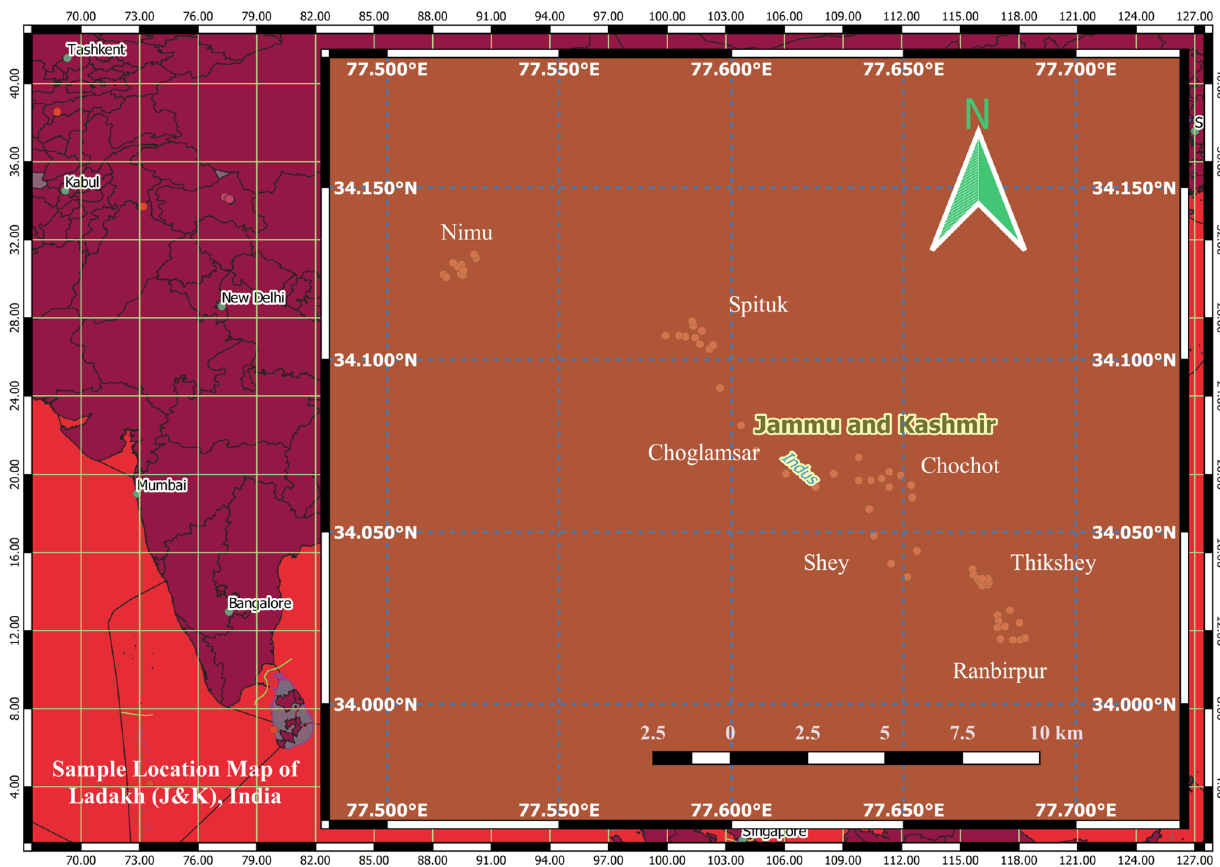
Fig. 1 Sample collection sites made by QGIS